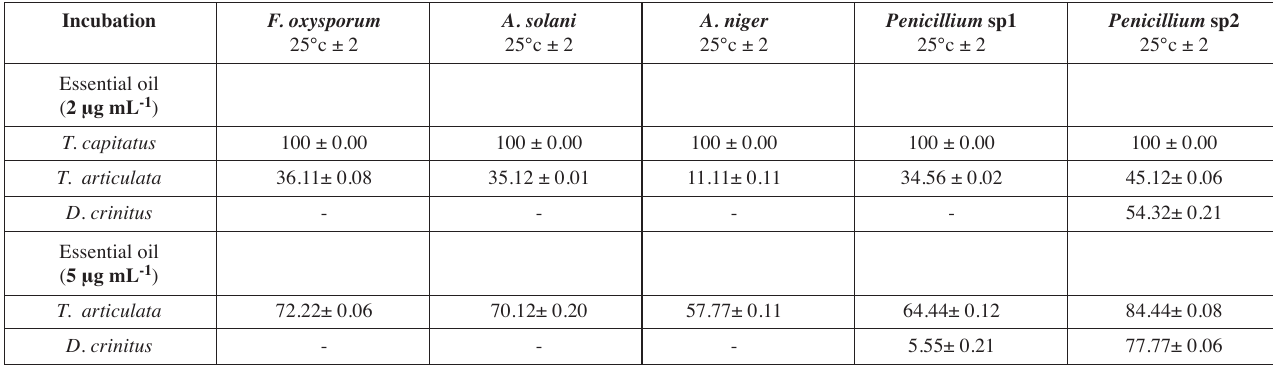
Tab. 2 : Percentage of inhibition of mycelial growth at various volumes of essential